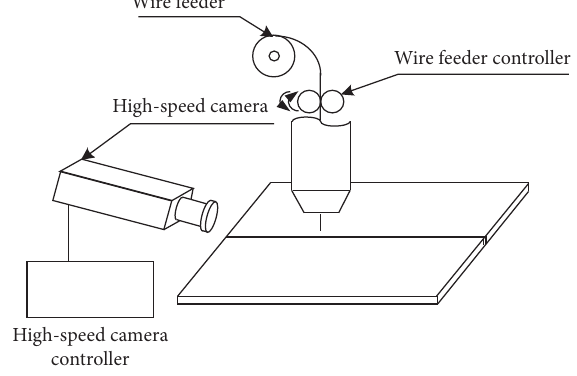
Figure 1: Welding schematic.